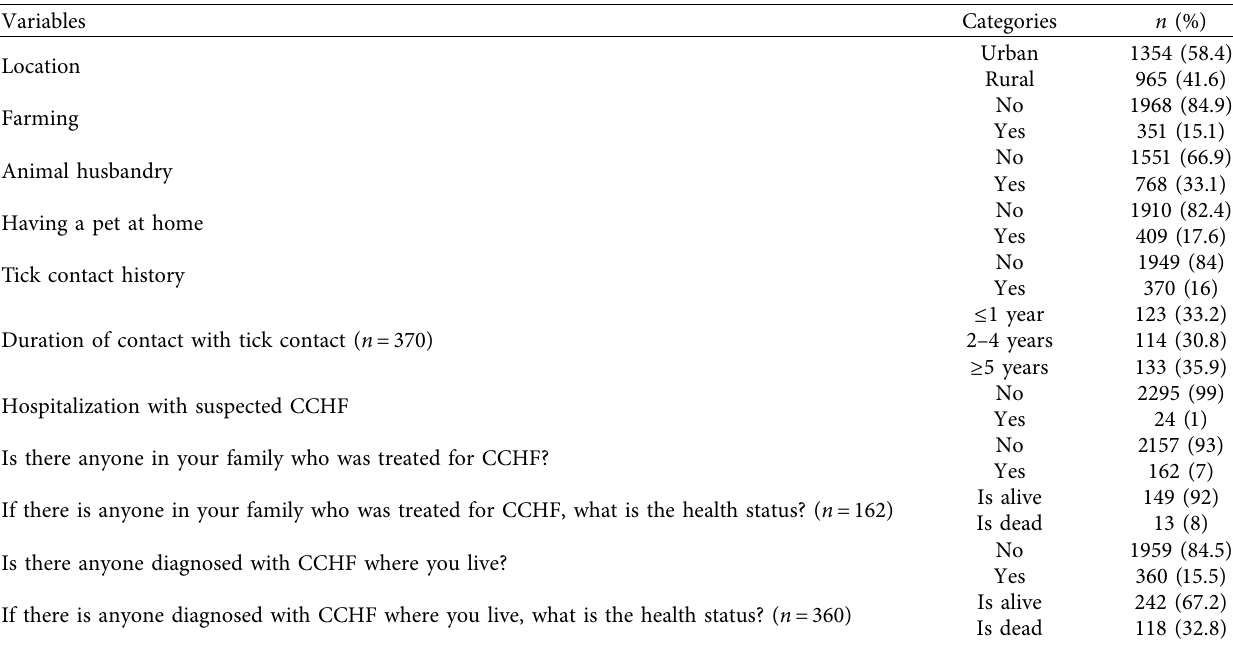
Table 2: Distribution of participants according to their characteristics related to some risk factors for